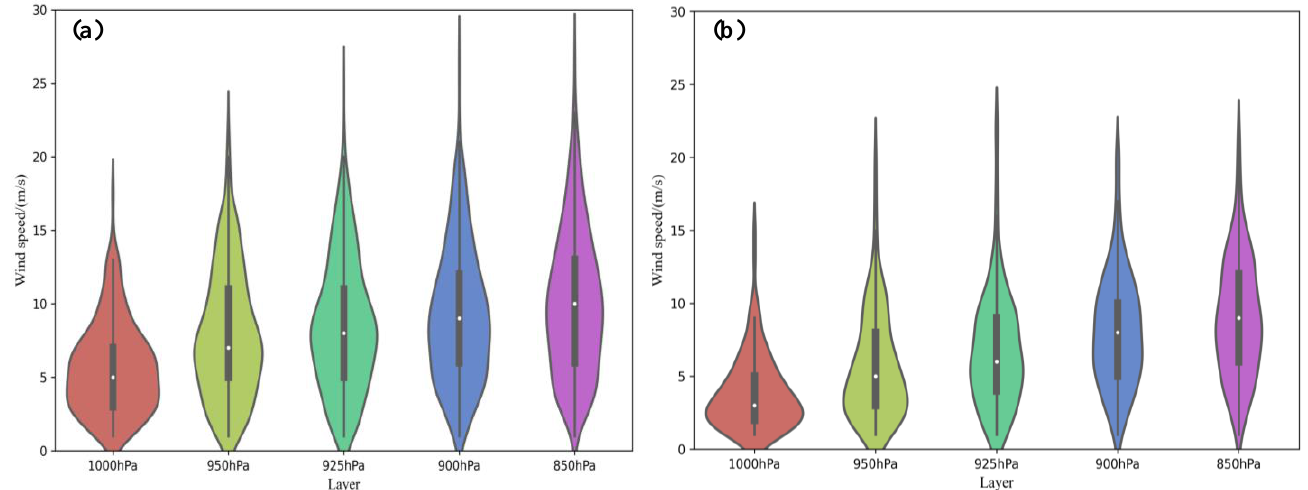
Figure 7. Observations of the wind speed during the clean days ( a ) and polluted days ( b ).